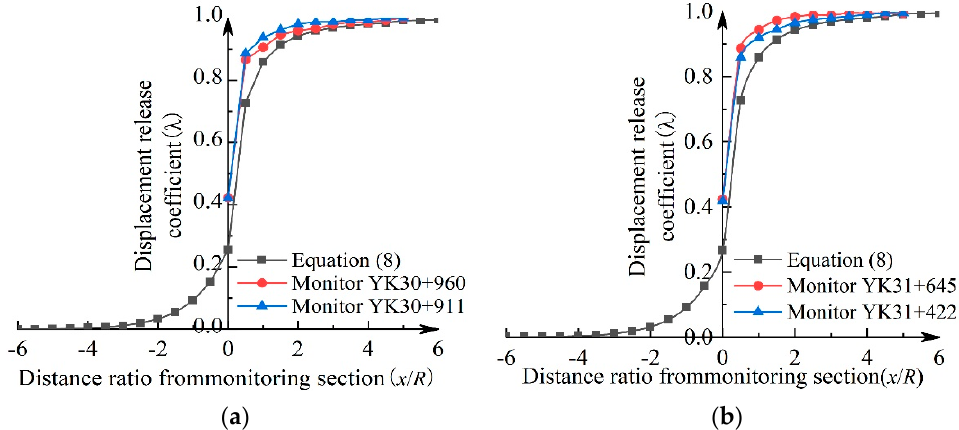
Figure 4. Monitoring and theoretical fitting diagram of vault displacement release coefficient: ( a ) Class − III surrounding rock; ( b ) Class − IV surrounding rock.